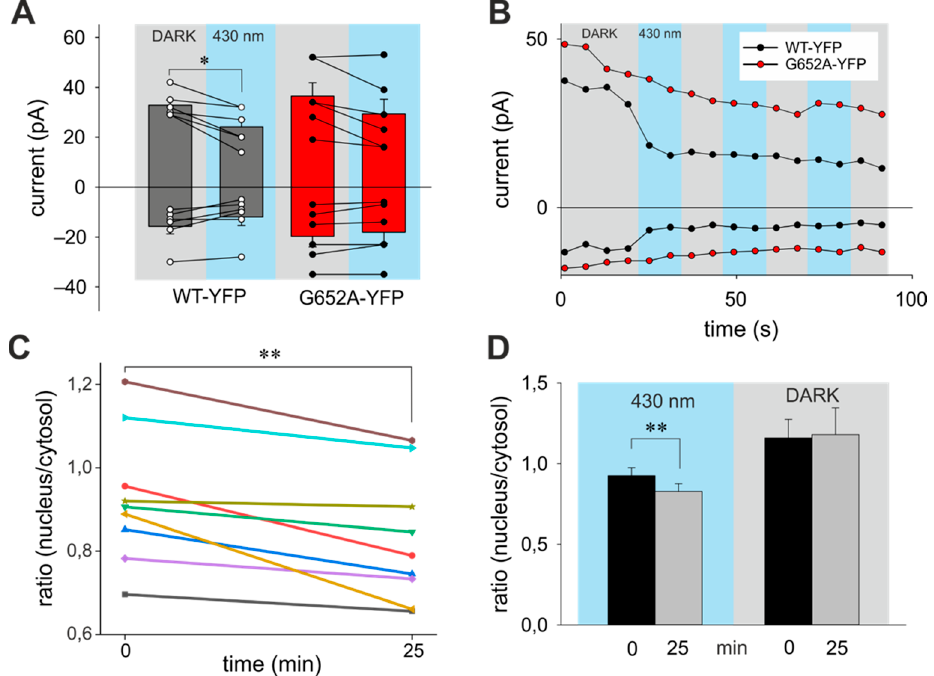
Figure 3. Trans photoisomerization of OptoBI-1 inhibits TRPC3 channel constitutive activity and basal NFAT1 nuclear localization. ( A ) Constitutive current levels of WT-YFP and G652A-YFP in presence of OptoBI-1 (10 μ M) during blue light administration. Currents are shown for − 90 and 70 mV (mean ± SEM). Statistical significance was tested by two tailed t-test (normally distributed values) or Mann–Whitney tests (non-normally distributed values), if not indicated—not significant ( p > 0.05); ( B ) Representative time courses of the WT-YFP (white) and G652A-YFP (red) conductances recorded at − 90 and 70 mV during repetitive photoconversion of OptoBI-1 (10 µ M). Light illumination cycling is indicated as grey (DARK) and blue (430 nm); ( C ) nucleus/cytosol NFAT1 distribution responses are shown for individual cells. Fluorescent levels before (0 min) and after (25 min) blue light-induced changes in cells transfected with WT-R-GECO in presence of OptoBI-1 (10 μ M; mean ± SEM); ( D ) mean ± SEM of nucleus / cytosol ratio NFAT1 translocation in WT-R-GECO-expressing HEK293 cells induced by OptoBi-1 non-illuminated (DARK) and illuminated with blue light stimulation (430 nm).